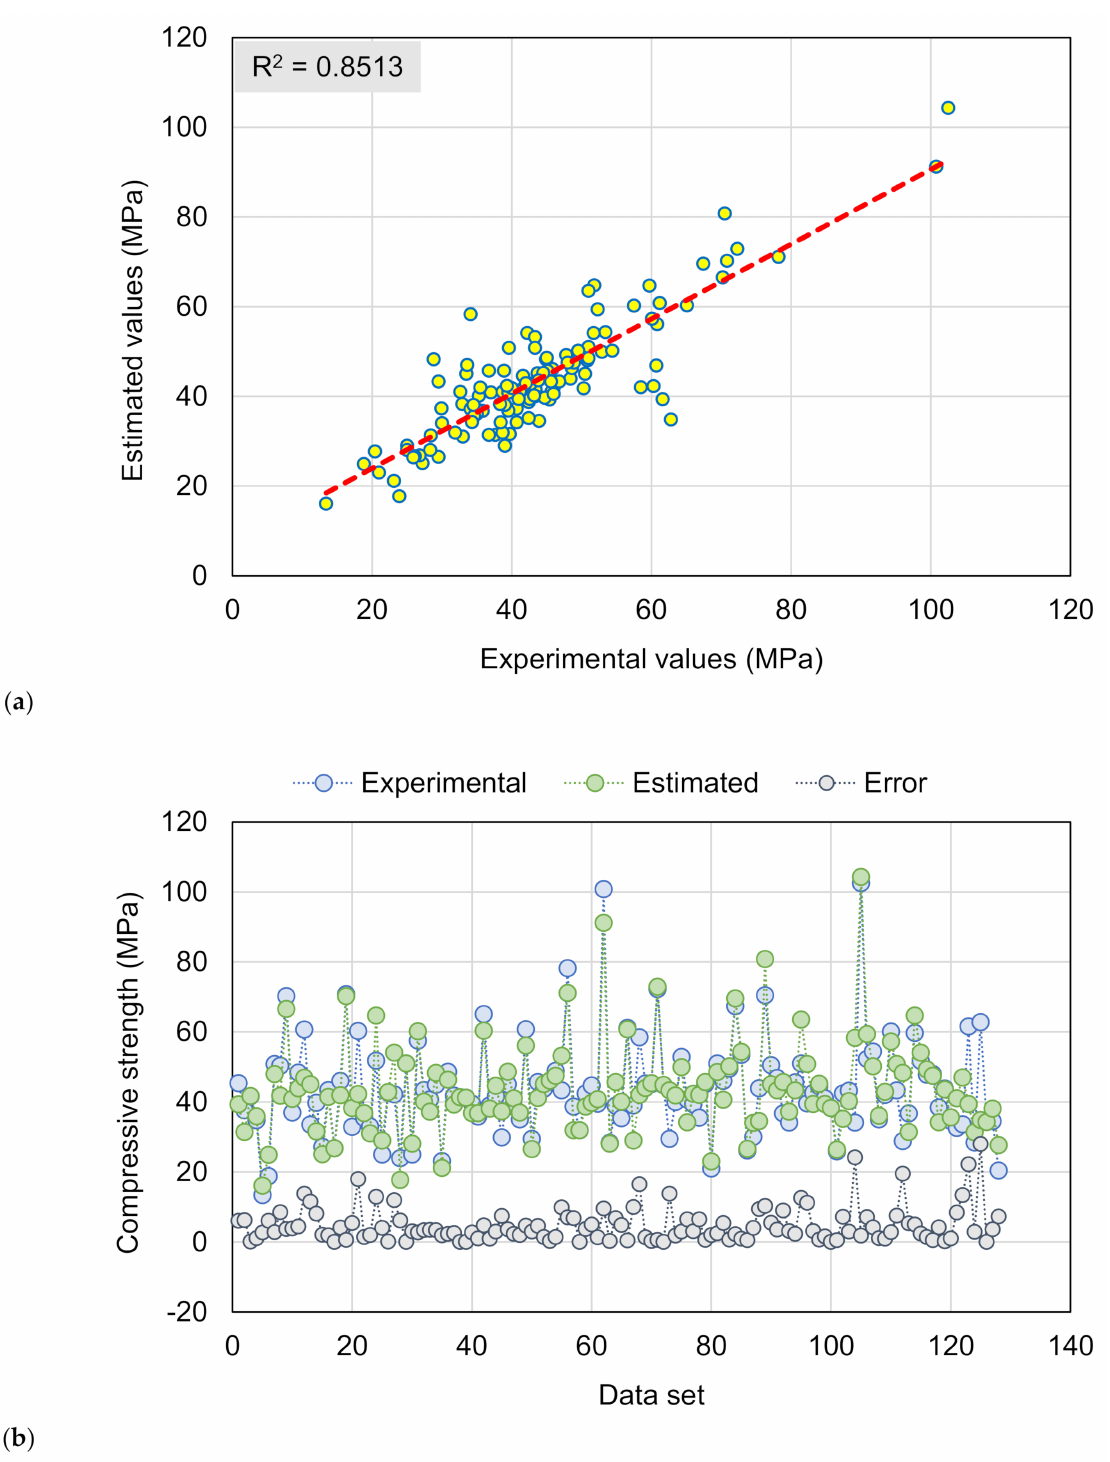
Figure 7. GB model: ( a ) Relationship among experimental and projected outcomes; ( b ) Scattering of actual and predicted